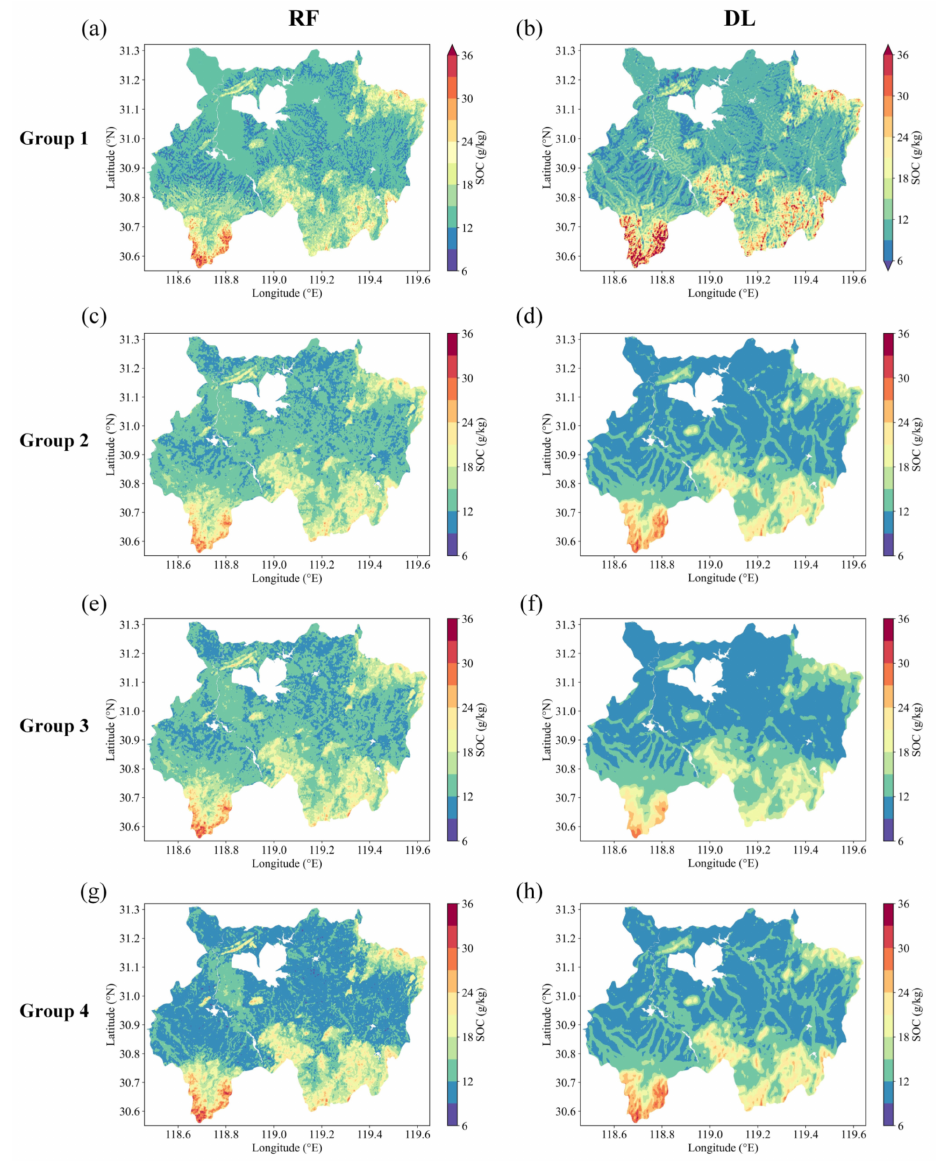
Figure 9. The predicted maps of soil organic carbon content (SOC) based on the deep learning (DL) ( a , c , e , g ) and random forest (RF) ( b , d , f , h ) models (shown in two columns) with four groups of covariates (shown in four